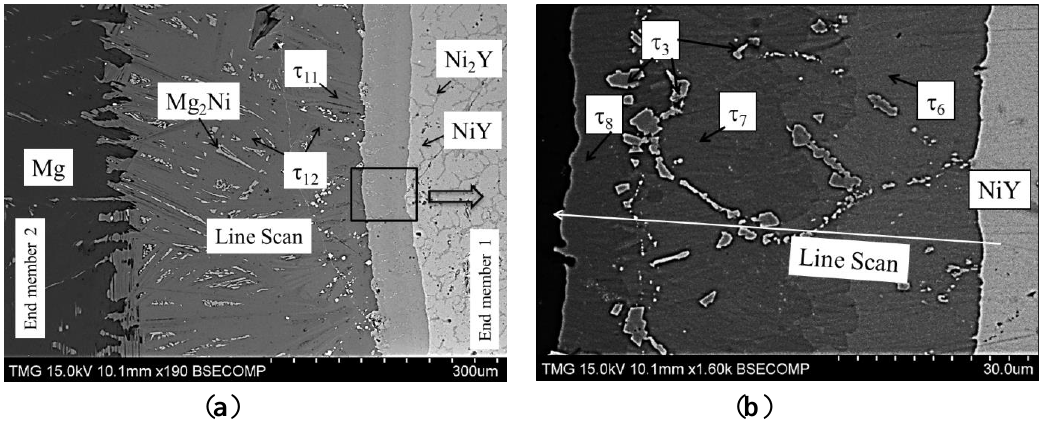
Figure 10. ( a ) BSE images of the solid–liquid diffusion couple-2 (Mg-Ni 52 Y 48 ) annealed at 673 K for 4 weeks; ( b ) Magnified area of